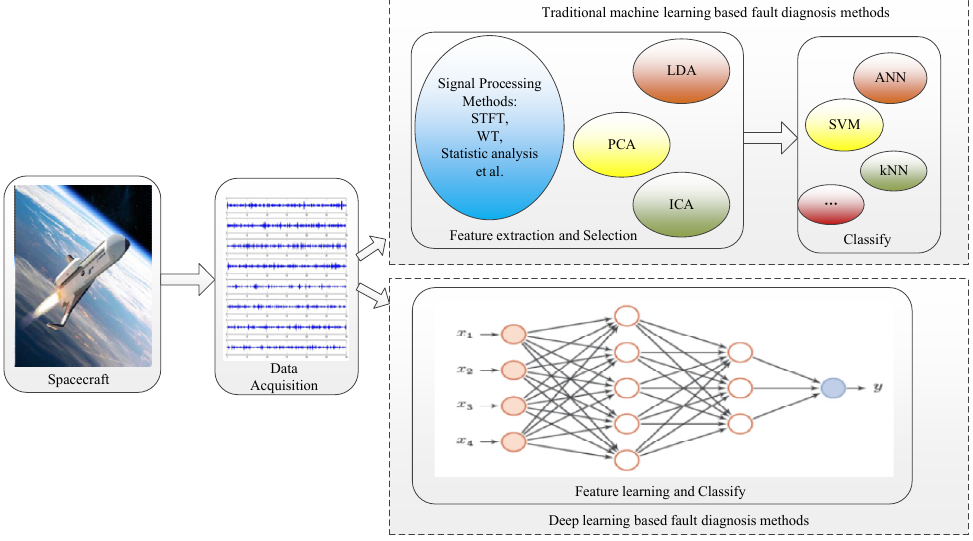
Figure 1. Machine learning- and deep learning-based fault diagnosis methods.